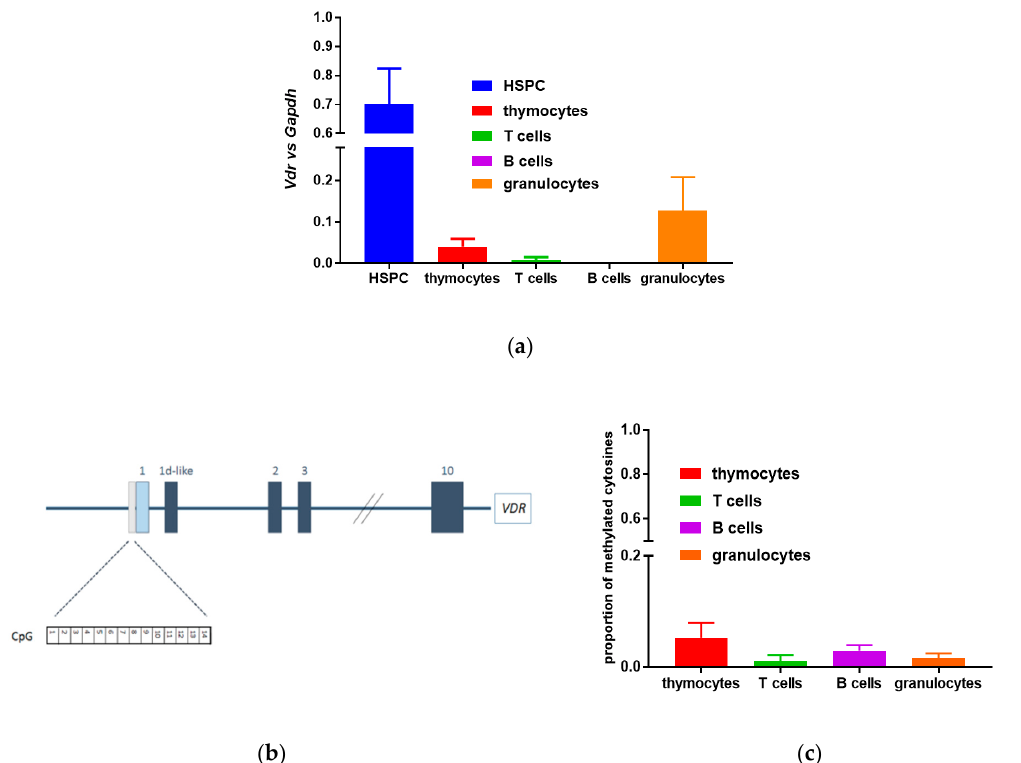
Figure 1. Expression of Vdr in different blood cells and methylation of CpG island in the promoter region of murine Vdr . ( a ) mRNA was isolated from murine blood cells and Vdr expression was measured by real ‐ time PCR relative to Gapdh mRNA levels. Expression in kidney cells was used as a calibrator. The bars represent mean values (±SEM) of the fold changes in mRNA levels. ( b ) A CpG